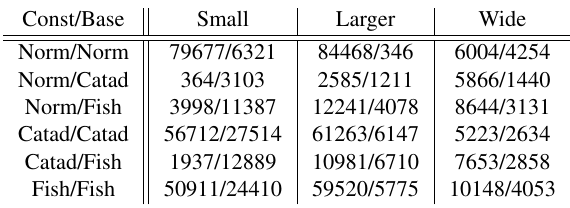
Table 2: Number of Matches for Different Camera Systems: This table lists the number of correct (error < 100 mm) matches vs the number of wrong matches.